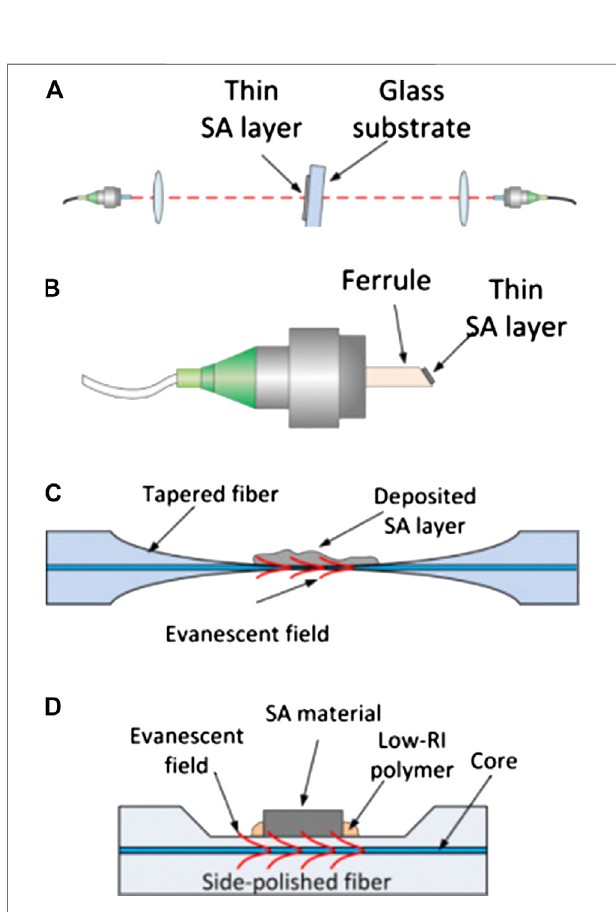
FIGURE 8 | Different types of SAs based on nanomaterials: (A) deposited on a glass plate, (B) on the end of the fi ber connector, (C) on a tapered fi ber, (D) on a side polished fi ber (RI Refractive index).